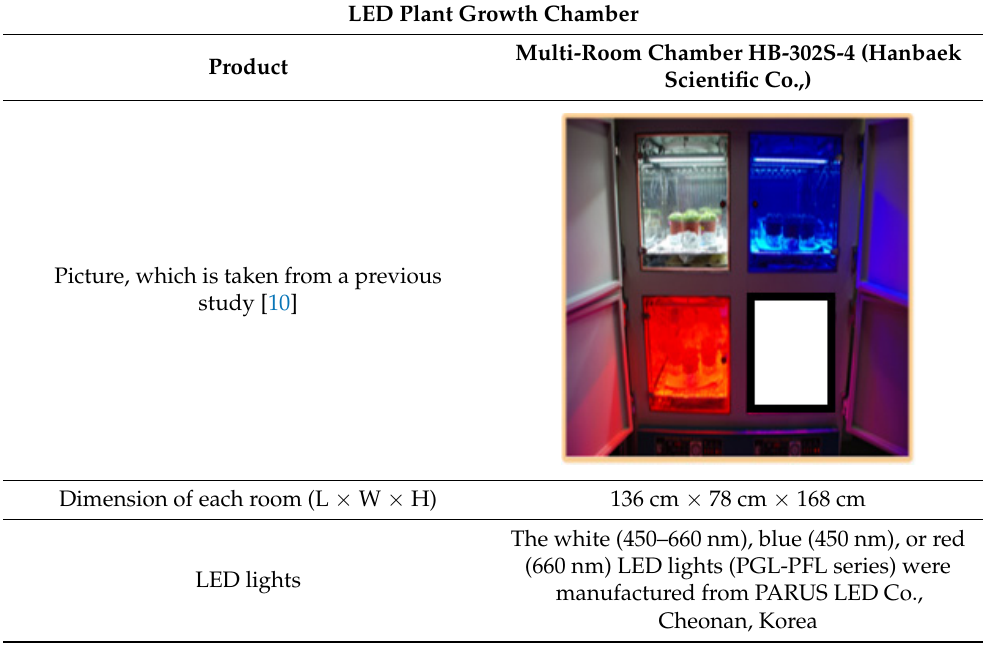
Table A2. HPLC analysis method.